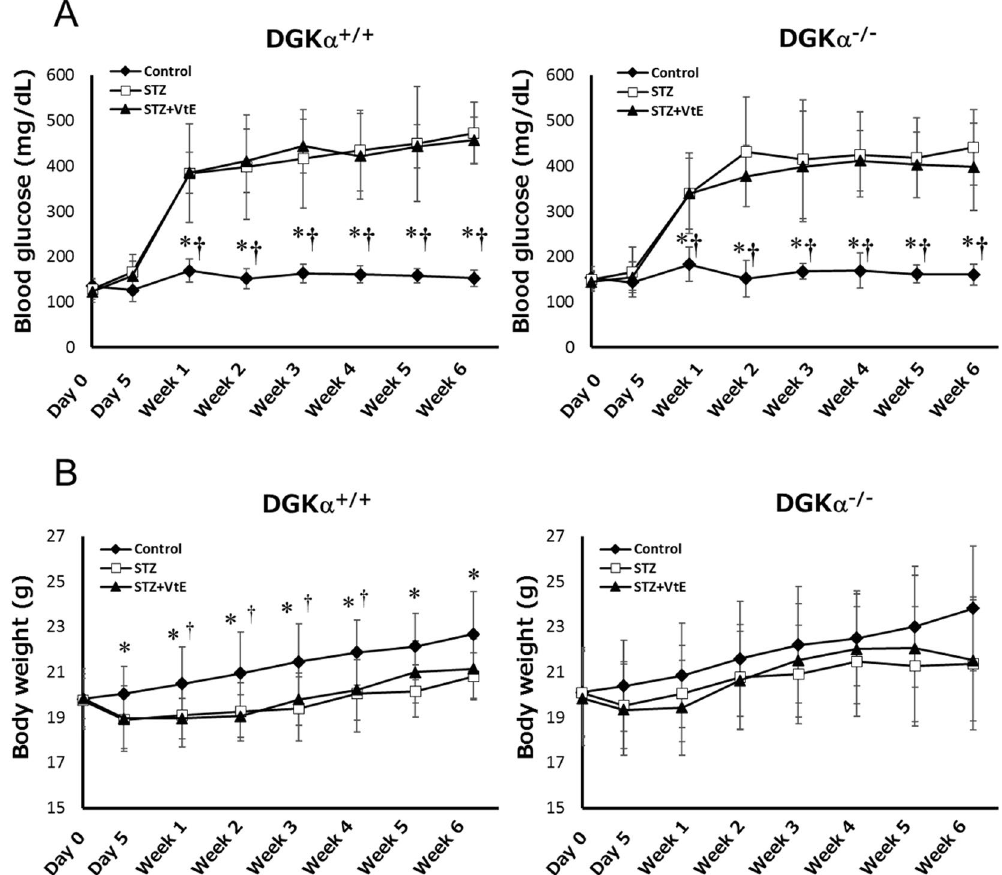
Figure 1. Changes in blood glucose levels and body weight. The blood glucose levels ( A ) and body weight ( B ) of the mice in each group were measured before and after STZ administration (day 0 and day 5), and every week thereafter until 6 weeks. Number of the mice in each group: DGK α + / + Control: n = 12~18, STZ: n = 13~20, STZ + VtE: n = 8~11, DGK α − / − Control: n = 12~18, STZ: n = 12~19, STZ + VtE: n = 9~11. * P < 0.01 vs. STZ; † P < 0.01 vs. STZ +